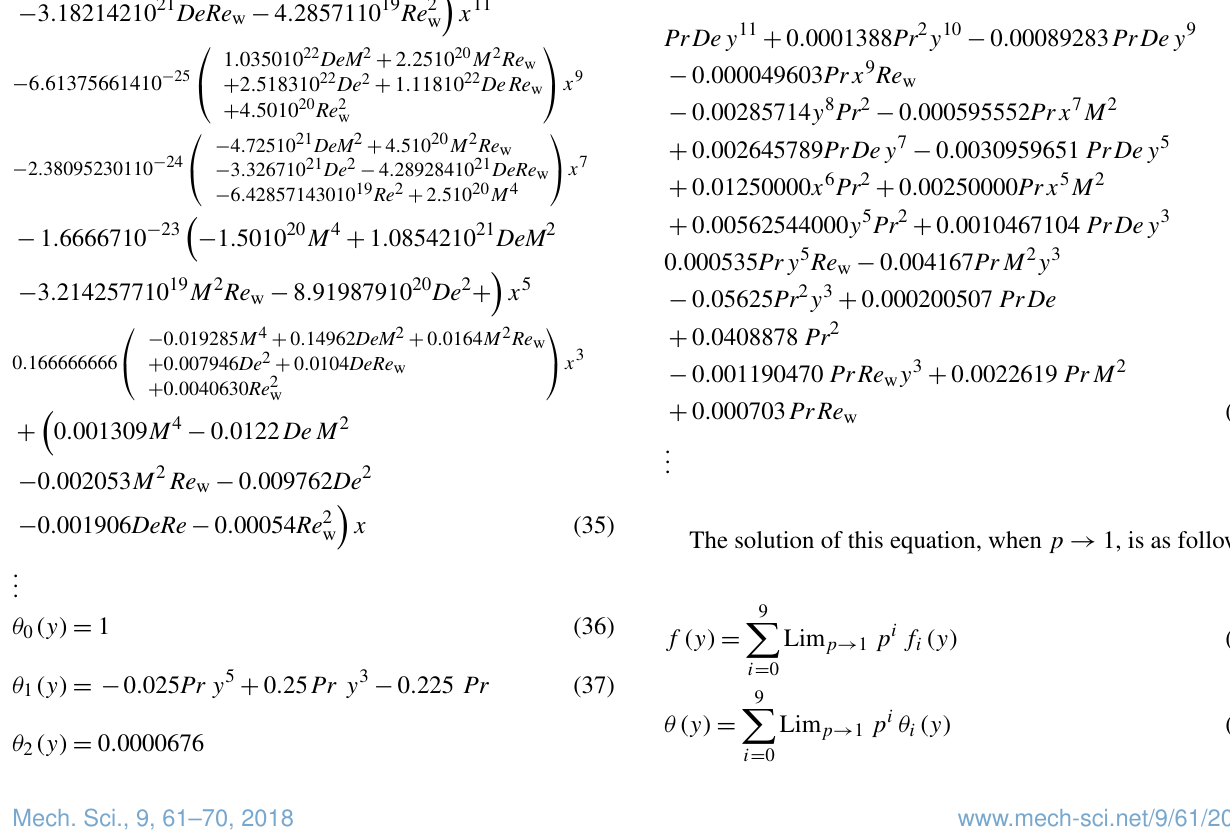
PrDe y 11 + 0 . 0001388 Pr 2 y 10 − 0 . 00089283 PrDe y